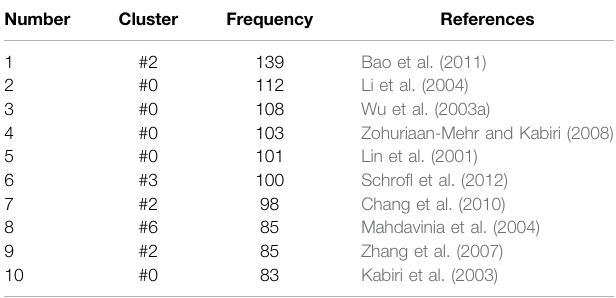
TABLE 3 | Top ten highest co-citation articles in the superabsorbent fi